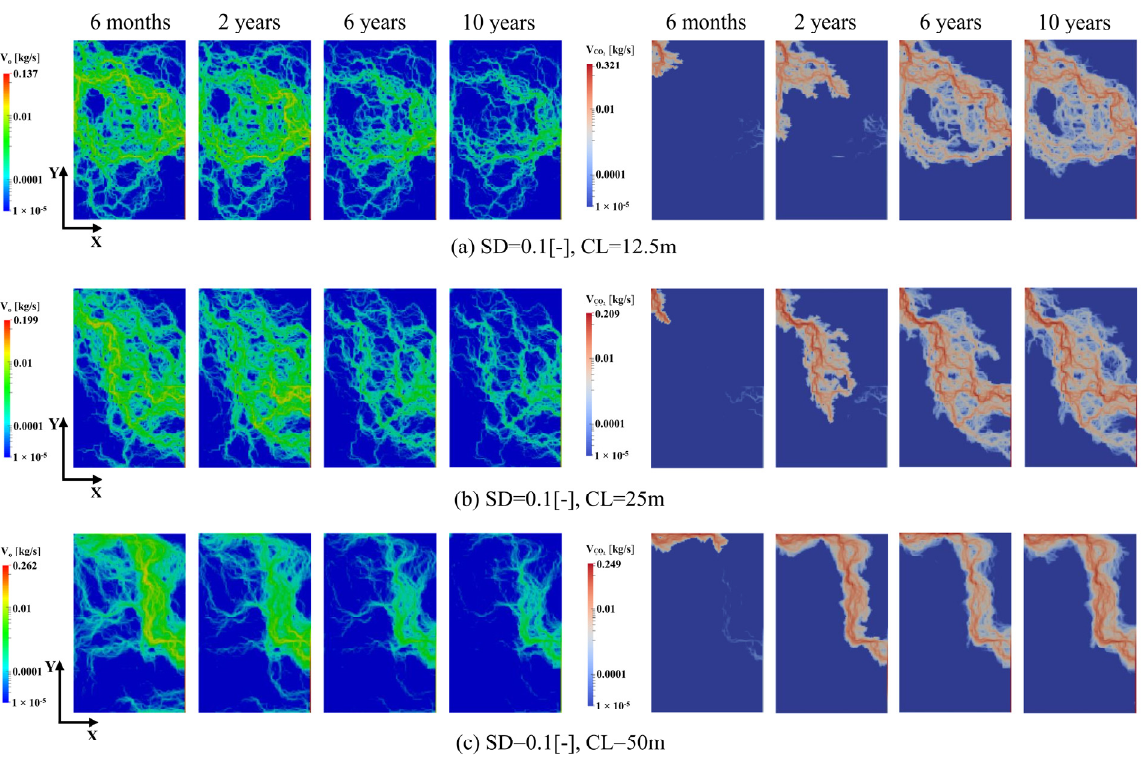
Figure 13. Evolutions of oil and CO 2 flow fields of Set 2. ( a ) SD = 0.05 (-), CL = 12.5 m; ( b ) SD = 0.05 (-), CL = 25 m; ( c ) SD = 0.05 (-), CL = 50 m.